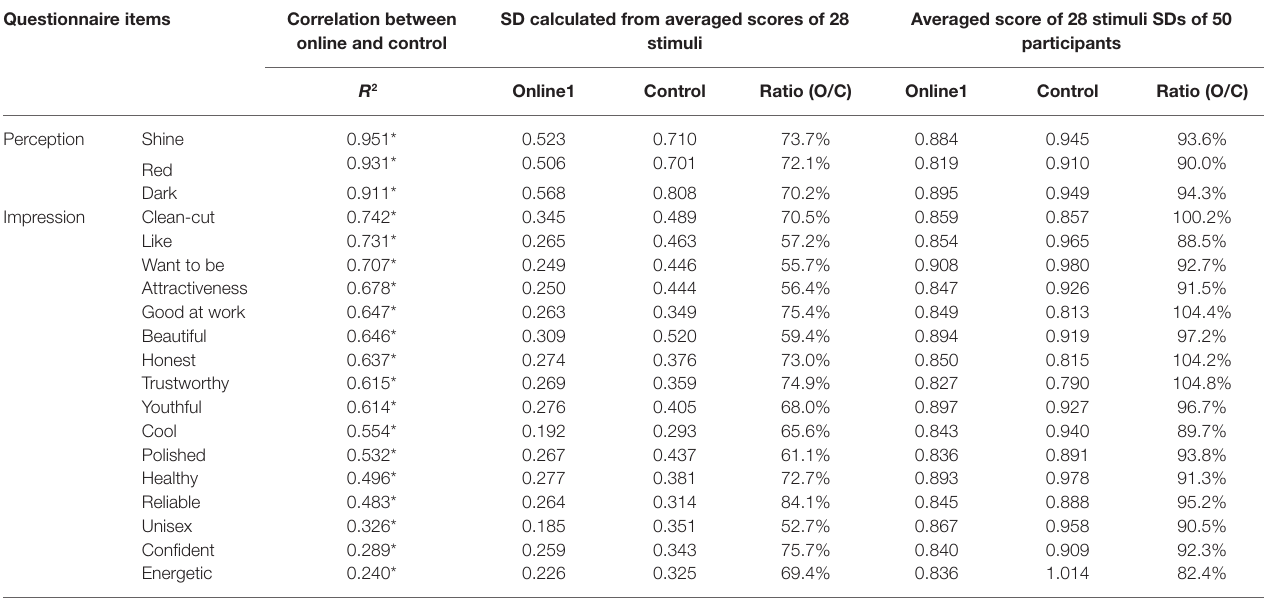
TABLE 1 | Correlations and differences of errors for each item for the Online1 and Control